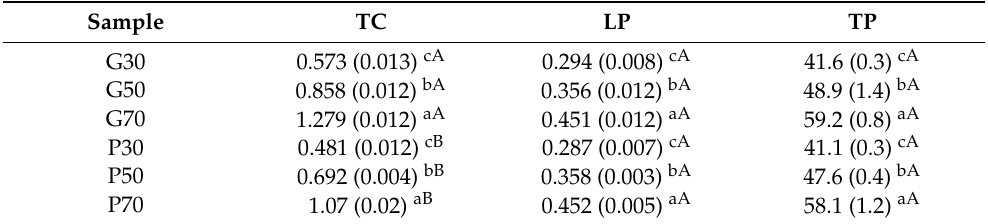
Table 8. Mean values (and standard deviations) of total carotenoids (TC, mg β -carotene/100 g), lycopene (LP, mg/100 g), and total phenols (TP, mgGA/100 g) of studied samples.